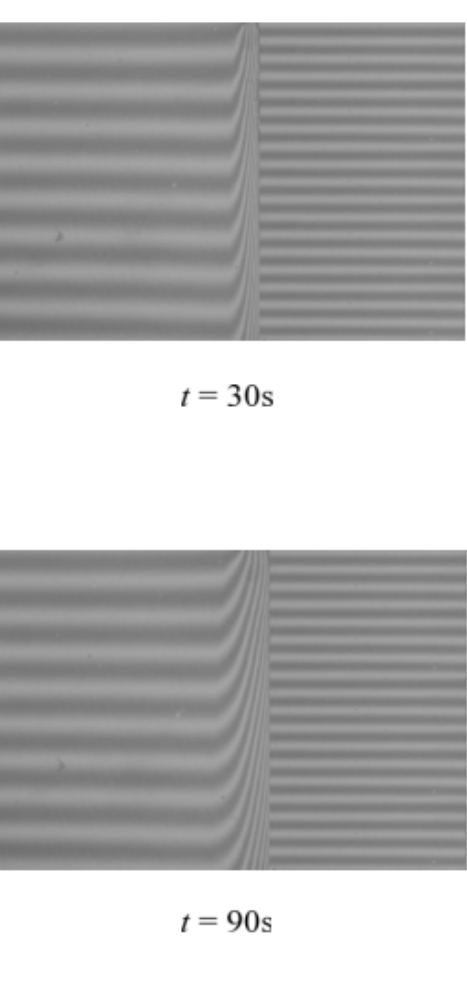
Figure 6. Swelling process illustrated by interferograms in time interval